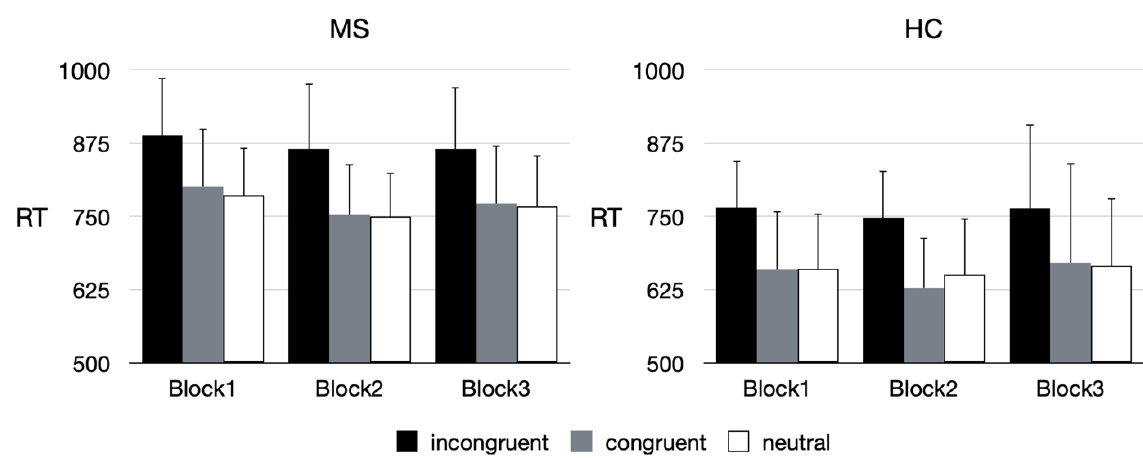
Figure 1. Reaction times for tasks, ExecAttent conditions, and Time blocks (Means + SD). Table 3. Reaction time analysis with factors Group, ExecAttent, and Time block: F, df (Greenhouse- Geisser corrected for within-subject effects), p and partial Eta². Non-integer df represent Green- house-Geisser adjusted degrees of freedom.